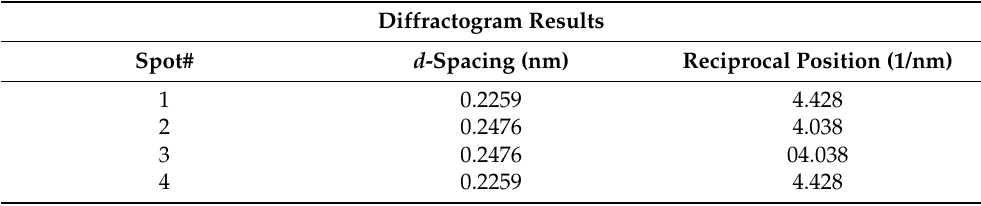
Table 2. Diffractogram results of the selected zone (Figure 9a).